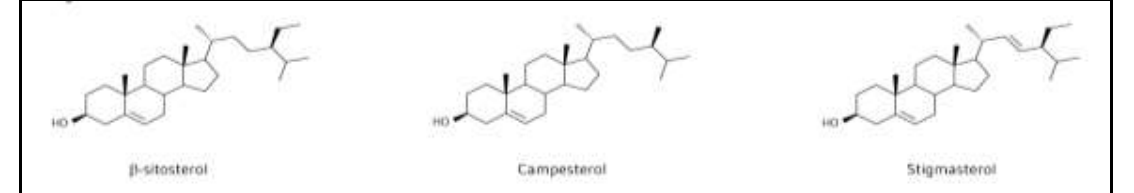
Figure 1. Chemical structure of selected